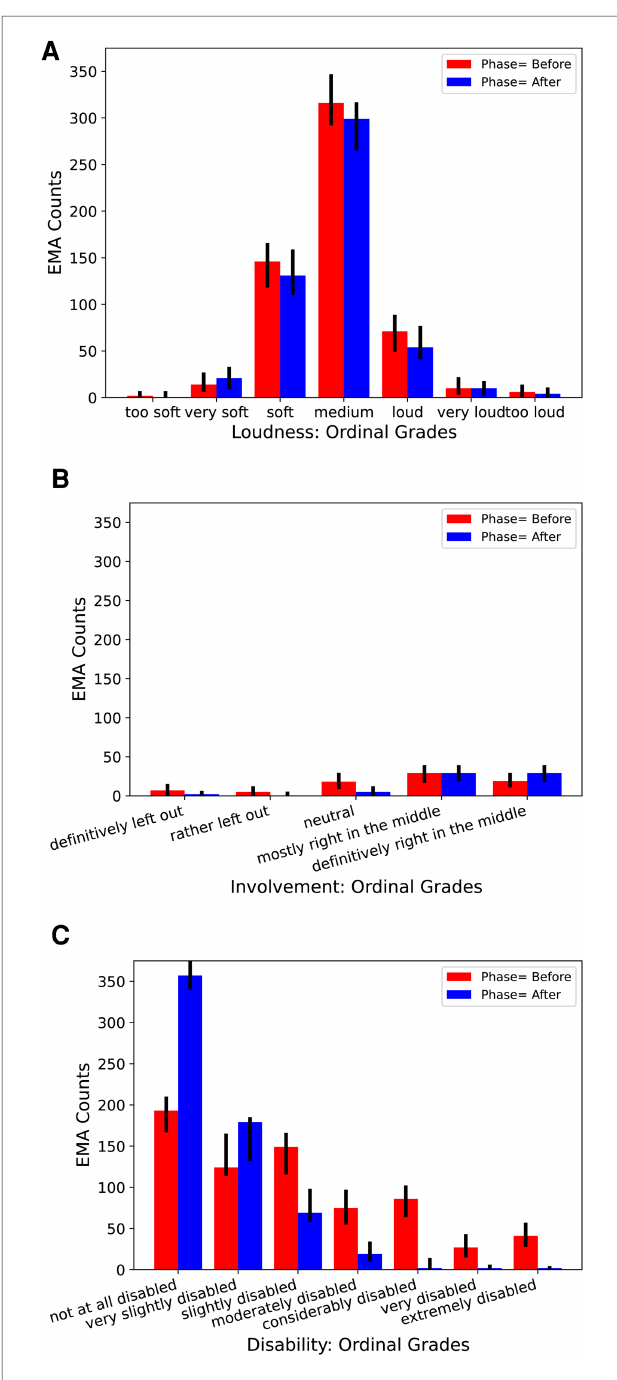
FIGURE 3 Histograms of ordinal ratings of ( A ) Loudness, ( B ) Involvement in group conversations, and ( C ) Disability in the two phases of the IHAB-RL study, summed across all CoSS categories and all 13 participants in two study phases, before and after hearing-aid fi tting. Short vertical black lines on top of the bars show corresponding model-predicted 95% credible intervals for the response